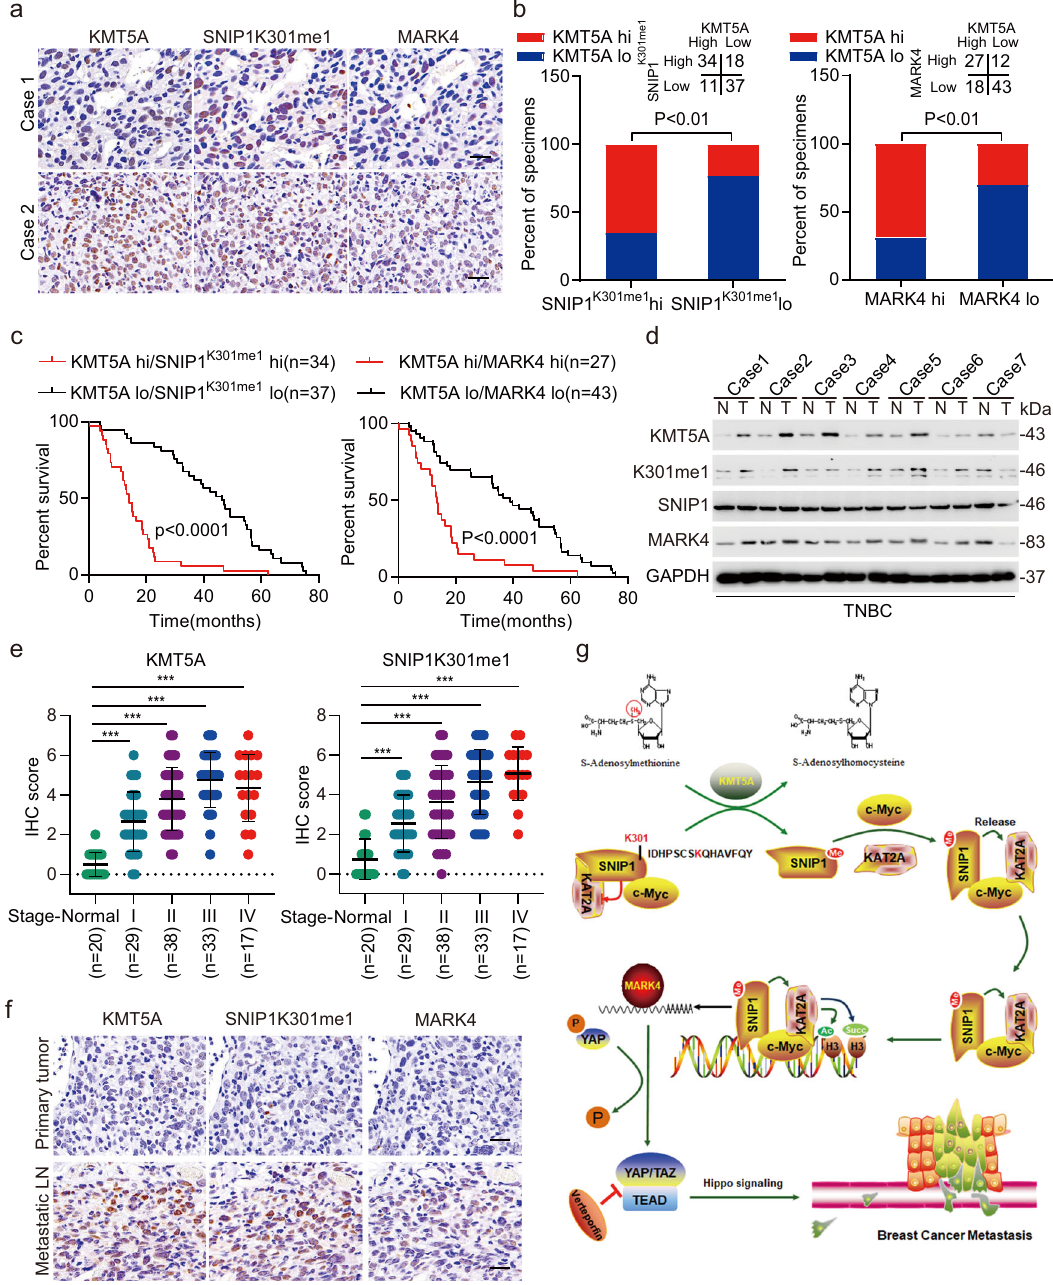
Fig. 8 KMT5A expression was signi fi cantly correlated with activated MARK4/YAP signaling in triple-negative breast cancer. a Representative images of KMT5A, SNIP1K301me1, and MARK4 in 100 clinical TNBC metastatic lymph node tissues. Scale bars, 50 μ m. b Correlation of expression levels between KMT5A, SNIP1K301me1, and MARK4 in ( a ). c Prognosis comparison of breast cancer patients with KMT5A/SNIP1K301me1 or KMT5A/MARK4